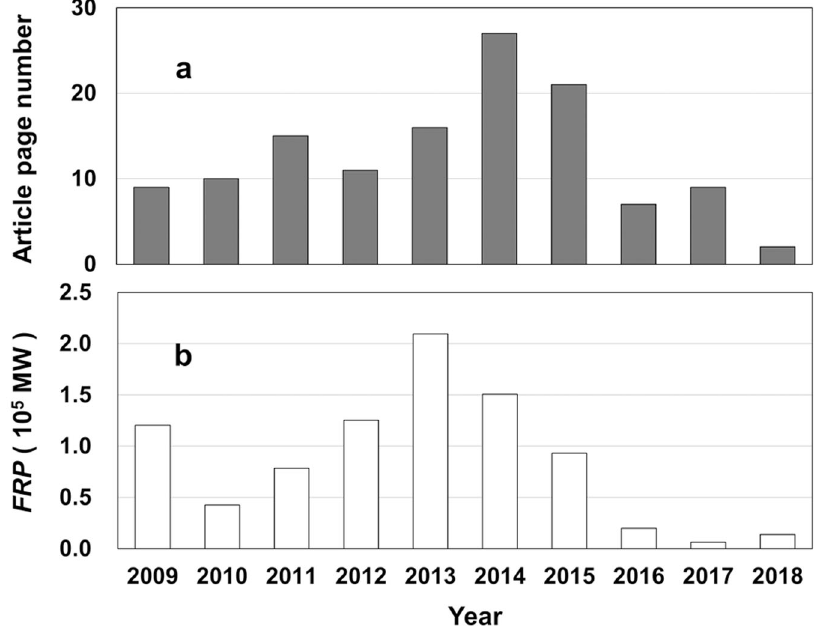
Fig. 6 Annual data for 2009 – 2018. a Article page number of “ acute respiratory illness ” + “ Pekanbaru ” , b FRP. R = 0.63 and 0.78 with time-lag zero and 1 year,